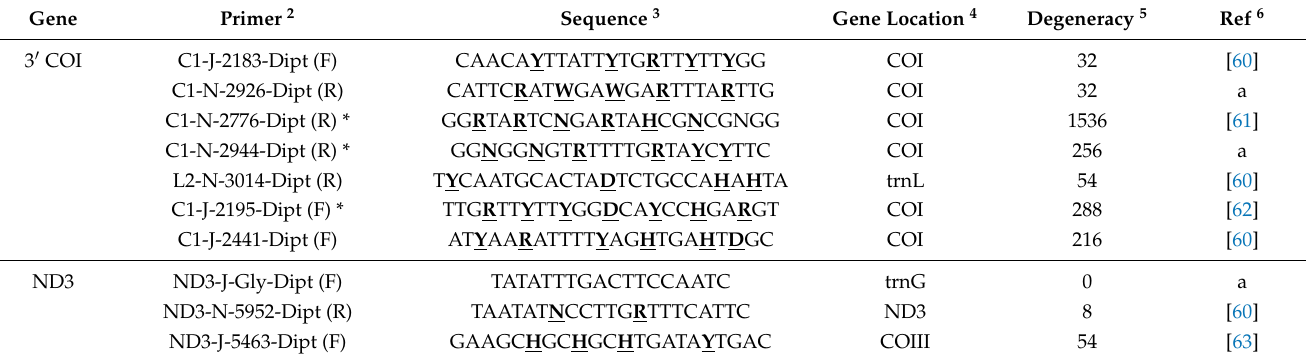
Table 2. All primer sequences for Diptera, either adapted from the literature or de-novo designed based on sequences available in GenBank 1 . Primers selected for final testing are marked